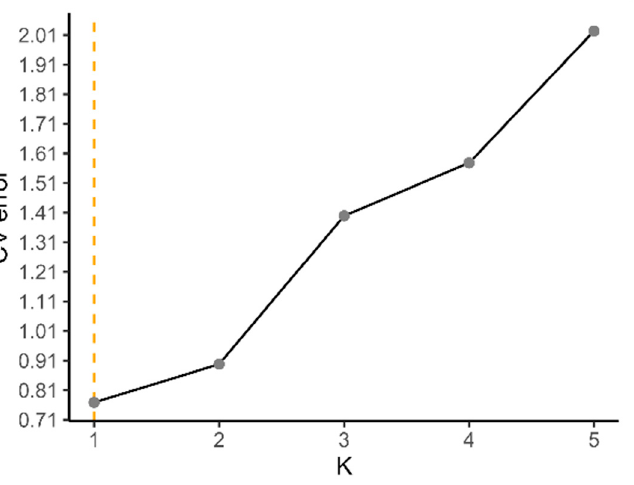
Figure 8. Admixture cross-validation (CV) error indicating the optimum number of clusters in the dataset.